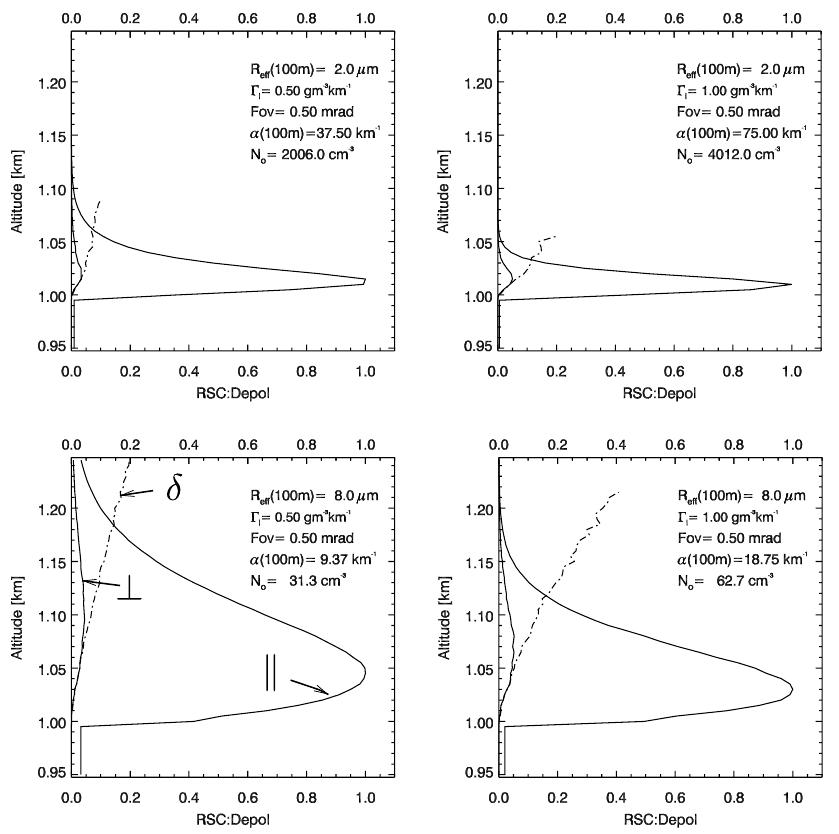
Figure 1. Example results MC calculations for a lidar wavelength of 355nm corresponding to semi-infinite clouds with a cloud base of 1.0km with the values of (cid:48) l and R eff at 100m as indicated in the top-right of each panel while γ = 9. Here the lidar FOV is 0.5mrad. As labelled in the bottom-left panel, the right-most solid line in each plot shows the parallel (para) range-corrected signal (RCS). The other solid line shows the corresponding perpendicular (perp) RCS and the dashed-dotted line shows the depolarisation ratio. Both the para- and perp-RCS profiles have been normalised by the maximum para